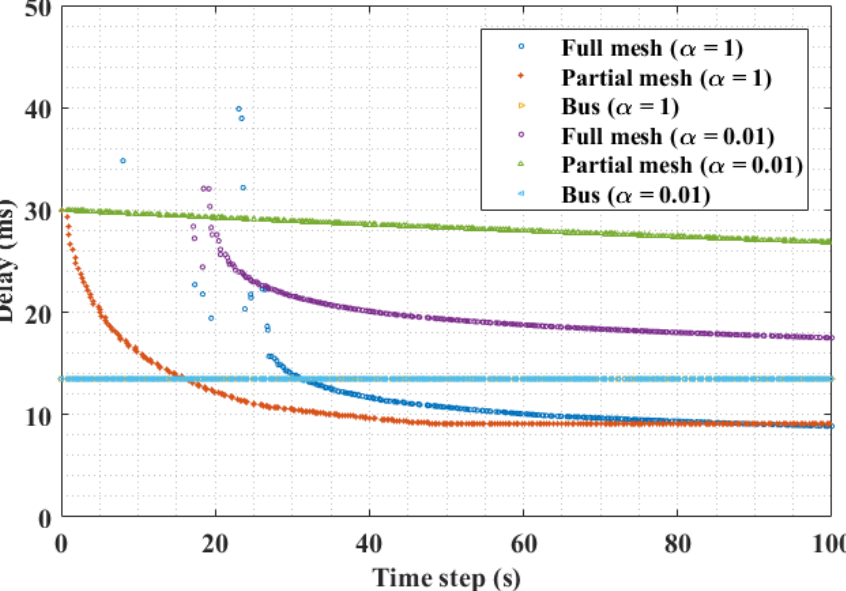
Figure 7. Convergence of the delay cost function for the 3 topologies for differing step sizes of 1 and 0.01.